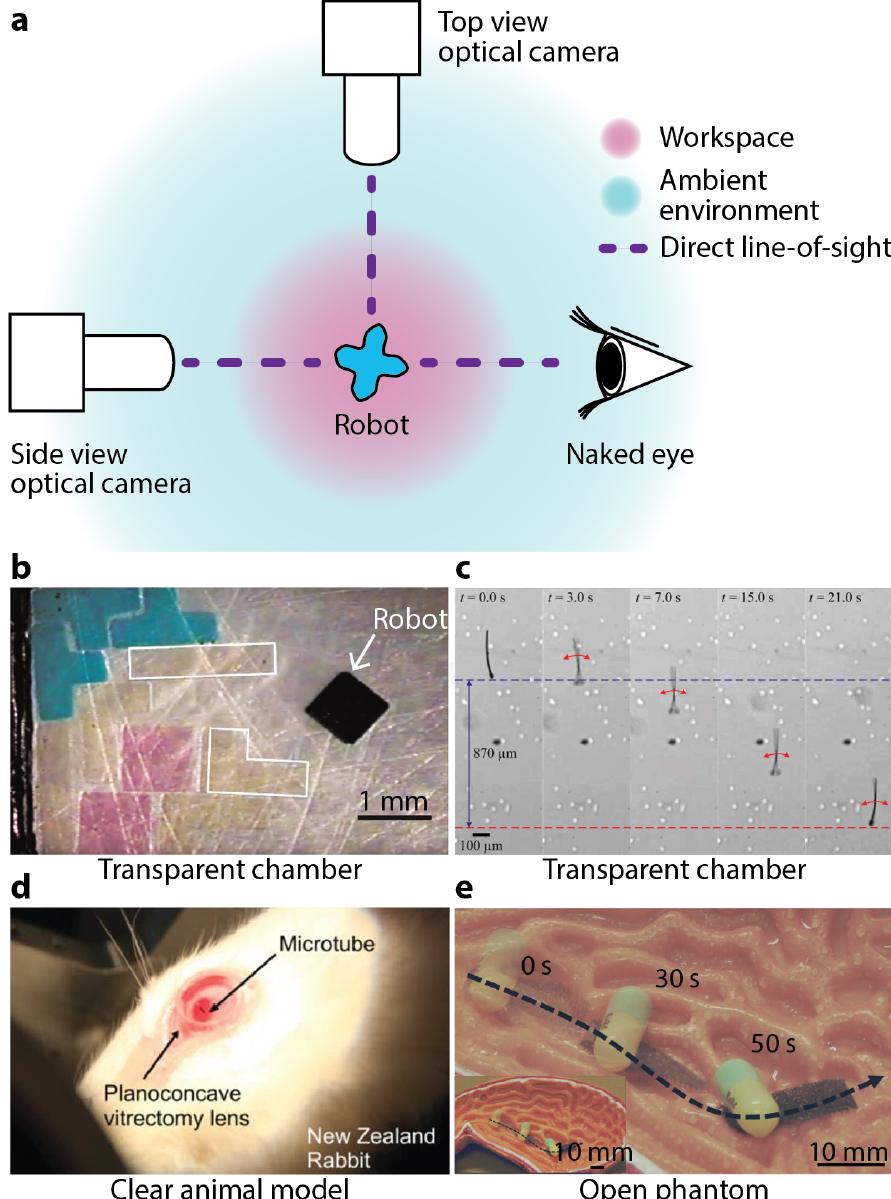
Figure 1. Conventional imaging setup for small-scale magnetic robots in laboratory environments. ( a ) Schematic illustration of a classic configuration in laboratory tests of small-scale magnetic robots. ( b ) Robot in a transparent chamber: A robot coded various material composition on a 2D substrate. Reproduced with permission from [26]. Copyright © 2014 Nature Publishing Group. ( c ) Robot in a transparent chamber: A sperm-like robot swam inside a transparent chamber. Reproduced with permission from [32]. Copyright © 2014 AIP Publishing. ( d ) Robot in a clear organ: A microrobot moving inside the vitreous humor of an anesthetized New Zealand rabbit. Reproduced with permission from [33]. Copyright © 2014 WILEY-VCH Verlag GmbH & Co. KGaA, Weinheim. ( e ) Robot in an open phantom: A millimetre-scale soft magnetic robot carried a drug pill in an open stomach model under wet environment. Reproduced with permission under a Creative Commons Attribution 4.0 International License